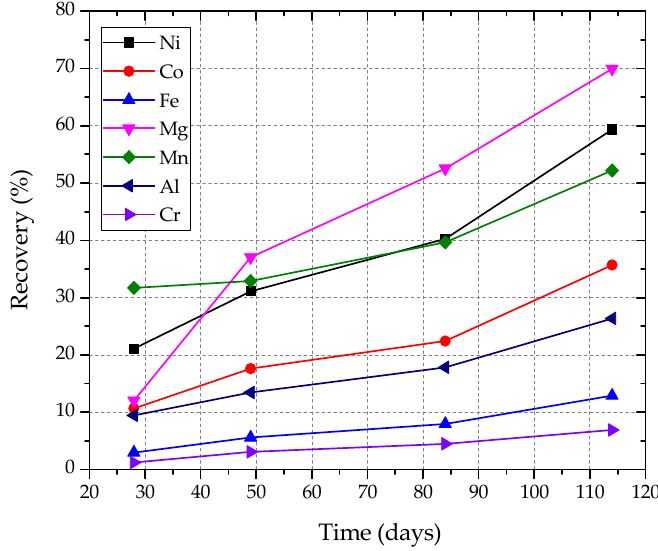
Figure 1. Nickel and cobalt recoveries and other cations dissolution with time during leaching.